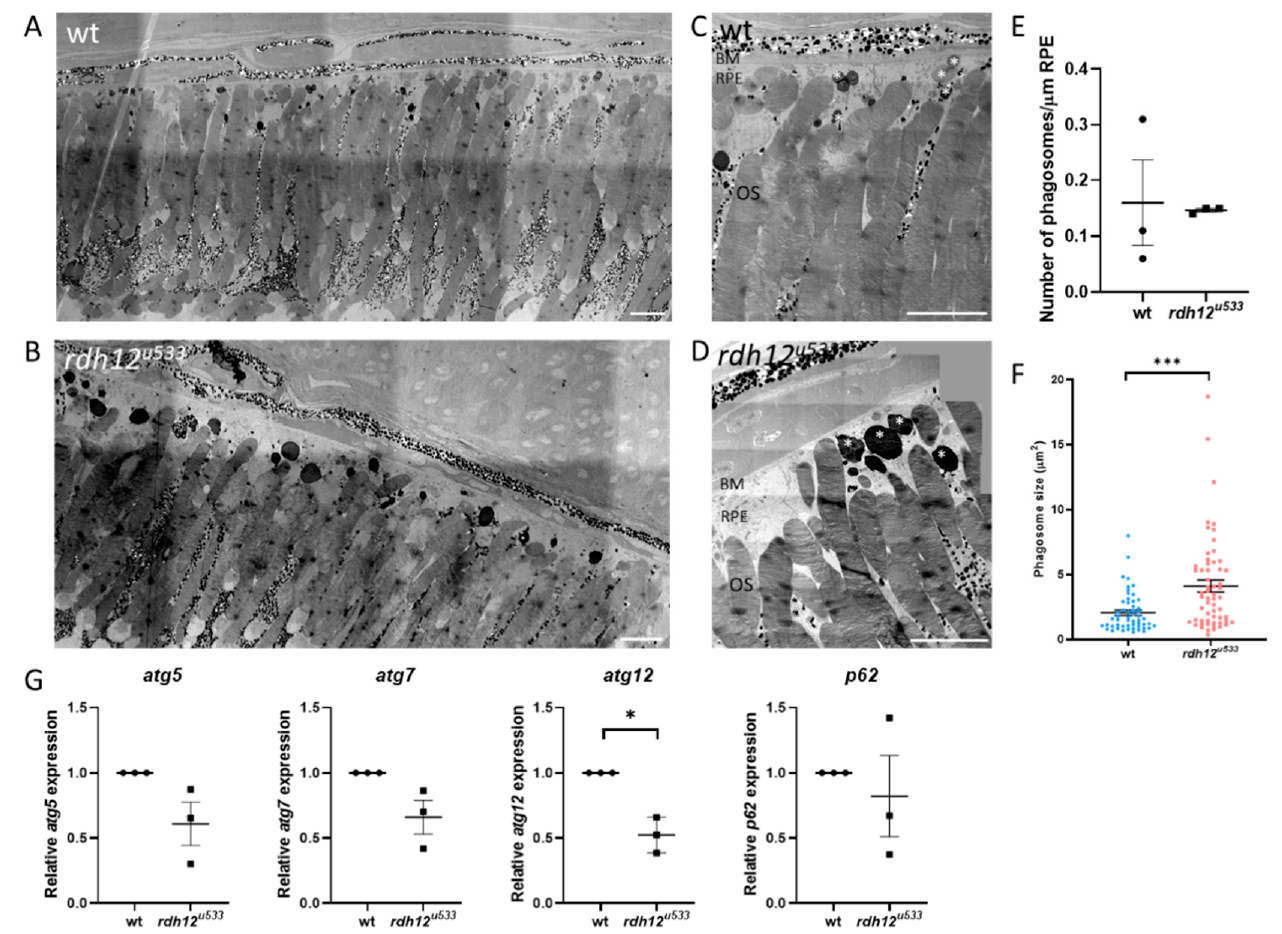
Figure 5. Retinal ultrastructure of wt and rdh12 u533 mutant fish. Transmission electron microscopy was used to assess retinal ultrastructure of wt ( A , C ) and rdh12 u533 ( B , D ) fish at 12 mpf. Phagosomes are indicated with white asterisks. Scale bar = 50 µ m. ( E ) No significant difference was noted in the number of phagosomes between wt and rdh12 u533 fish. ( F ) Phagosomes were significantly larger in the rdh12 u533 fish at 12 mpf. Data are displayed as mean ± SEM. Phagosome number and size was quantified using ImageJ from three wt and rdh12 u533 fish. Statistical significance was analysed by Mann–Whitney, *** p ≤ 0.001. ( G ) mRNA expression of autophagy genes in the retina of 12 mpf fish was analysed by RT-qPCR. Expression of atg12 was significantly reduced in the rdh12 u533 fish. * p ≤ 0.05. OS, outer segment; RPE, retinal pigment epithelium; BM, Bruch’s membrane.